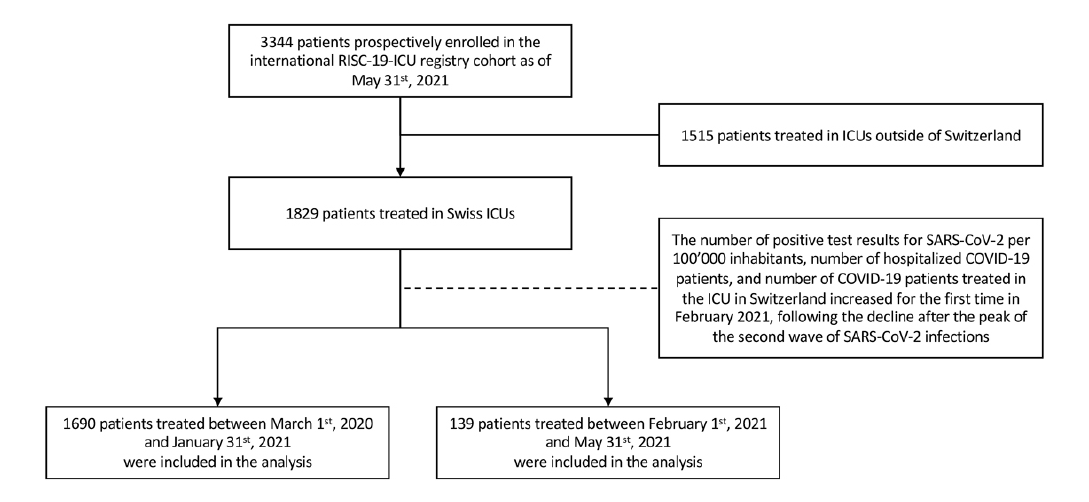
Figure 2: Patient enrolment within the RISC-19-ICU registry, patient selection and group assignment for the comparison of patients admitted during the third wave of SARS-CoV-2 infections in Switzerland with the previous pandemic course.